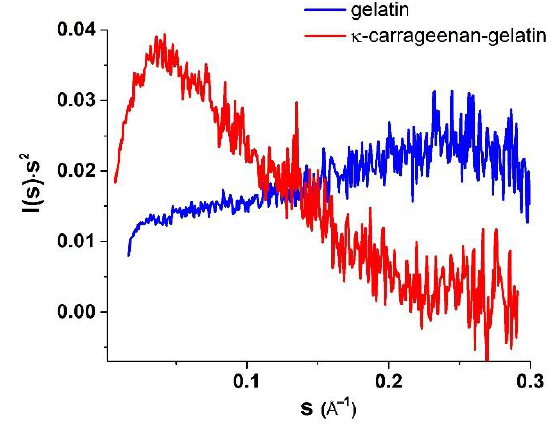
Figure 5. Structural schemes of spherical ( A ) and cylindrical ( B ) models indication of determined parameters. Additional confirmation of this assumption is presented in our other article [17]. On the base of FTIR spectroscopy and molecular docking it was proposed that in the κ -carra- geenan – gelatin hydrogels the most energetically favorable configuration of junctions was the interaction of the gelatin triple helix segments and the κ -carrageenan double helix. Both components of the composite hydrogel and their junctions formed the rod-shaped and rigid local structures, resulting in an anisotropic structural network, which can be hypothetically imagined as elongated particles between nodes. Such a highly anisotropic system can be depicted as the ensemble of cylindrical particles with an average length L and cross section r c , which can be obtained from the experimental value of the gyration dimension of the cross-section R c using the modified Guinier plots (ln( s ∙I( s )) vs. s 2 ) [38]. In the special case of anisometric particles, the two-dimensional analogue of gyration radius R g is called the cross-section gyration radius R c [38]. These parameters are also presented in Table 1. Note that for a gel sample based on pure gelatin, it was not possible to identify